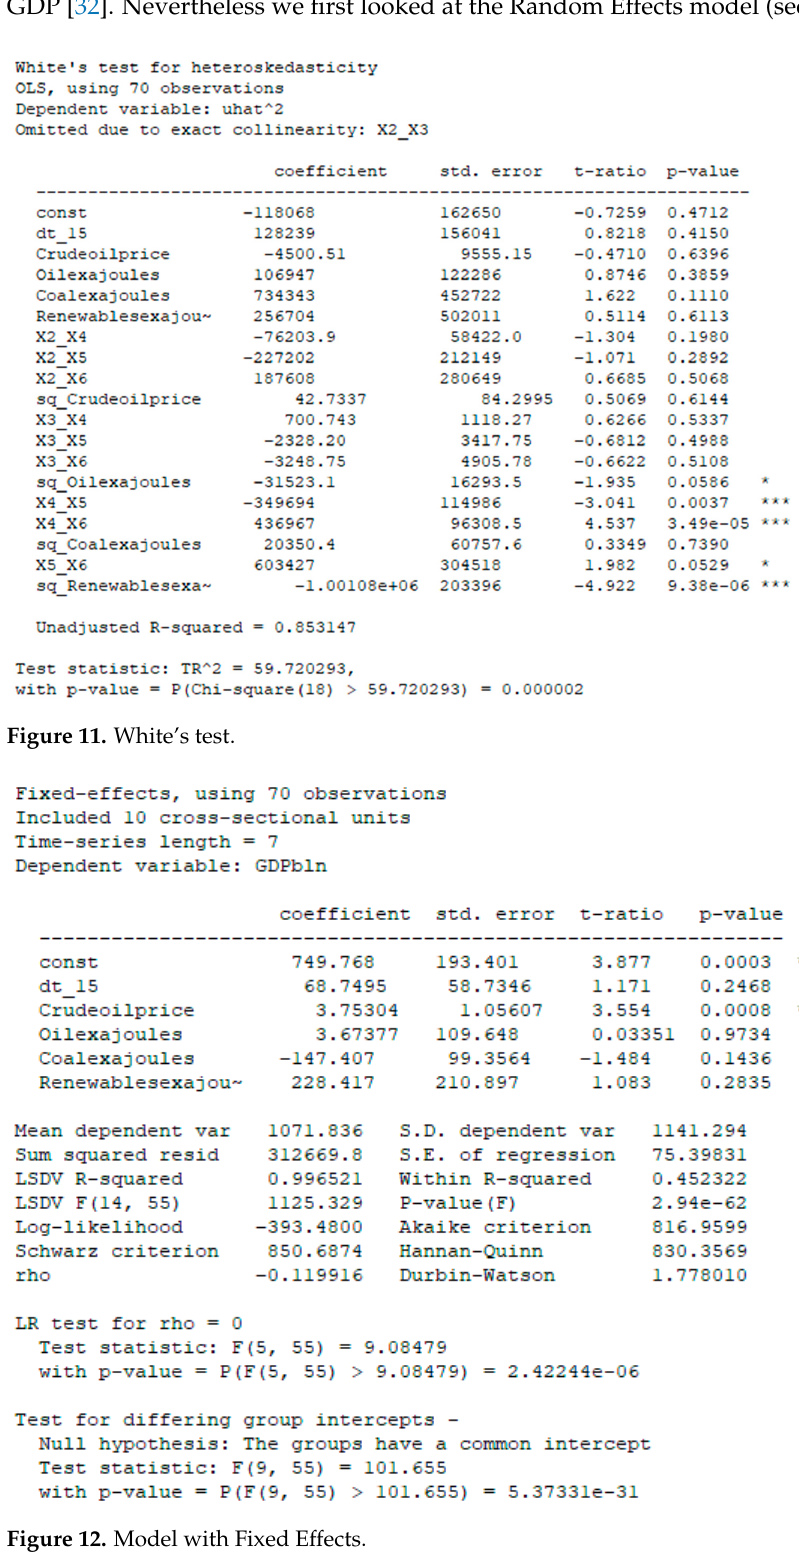
Figure 10. Critical value for Fisher test.